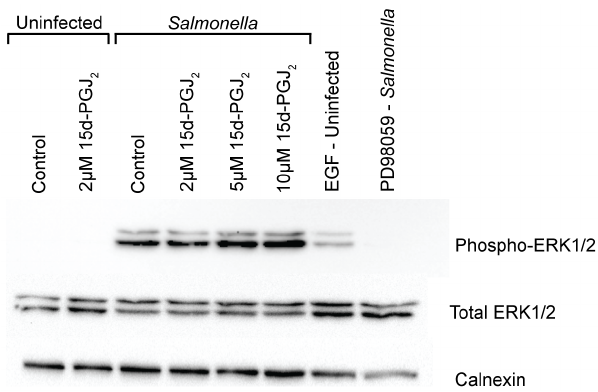
Figure 8. Phosphorylated ERK1/2 levels increase with 15d-PGJ 2 treatment. Phosphorylated ERK1/2 levels are increased 1 hour after Salmonella infection of RAW264.7 macrophages treated with increasing concentrations of 15d-PGJ 2 . Figure is representative of 3 independent experiments.